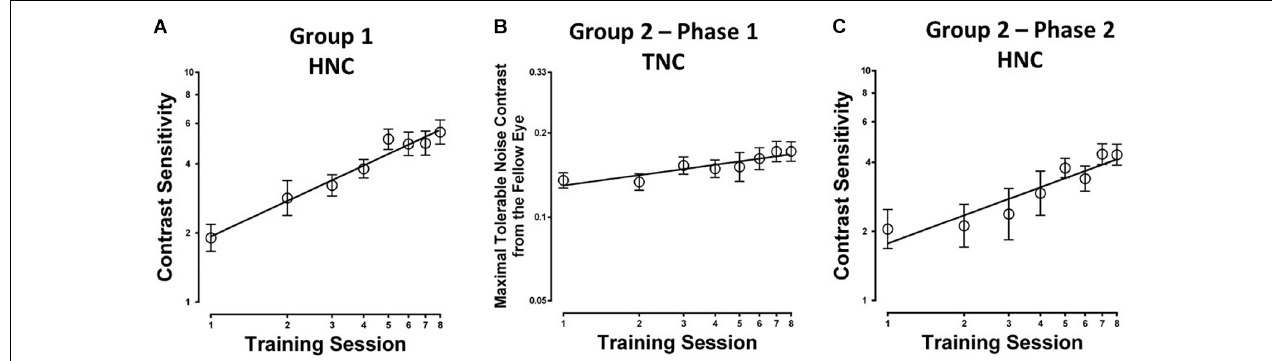
FIGURE 2 | Learning curves for the two different training protocols in amblyopic participants from (A) Group 1 with constant and high noise contrast in the fellow eye (HNC), (B) Group 2 (Phase 1) with progressively elevated noise contrast in the fellow eye (TNC); (C) Group 2 (Phase 2), HNC training.